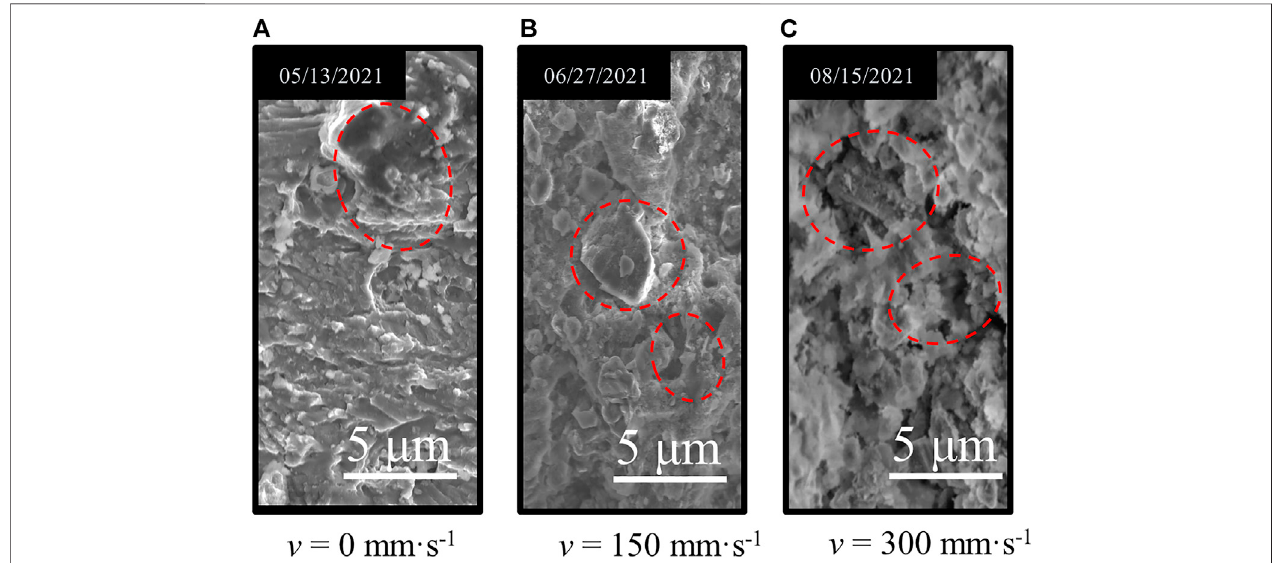
FIGURE 4 | Microstructural damage of granite immersed at different solution fl ow rates. (A) v = 0 mm · s -1 . (B) v = 150 mm · s -1 . (C) v = 300 mm · s -1 .